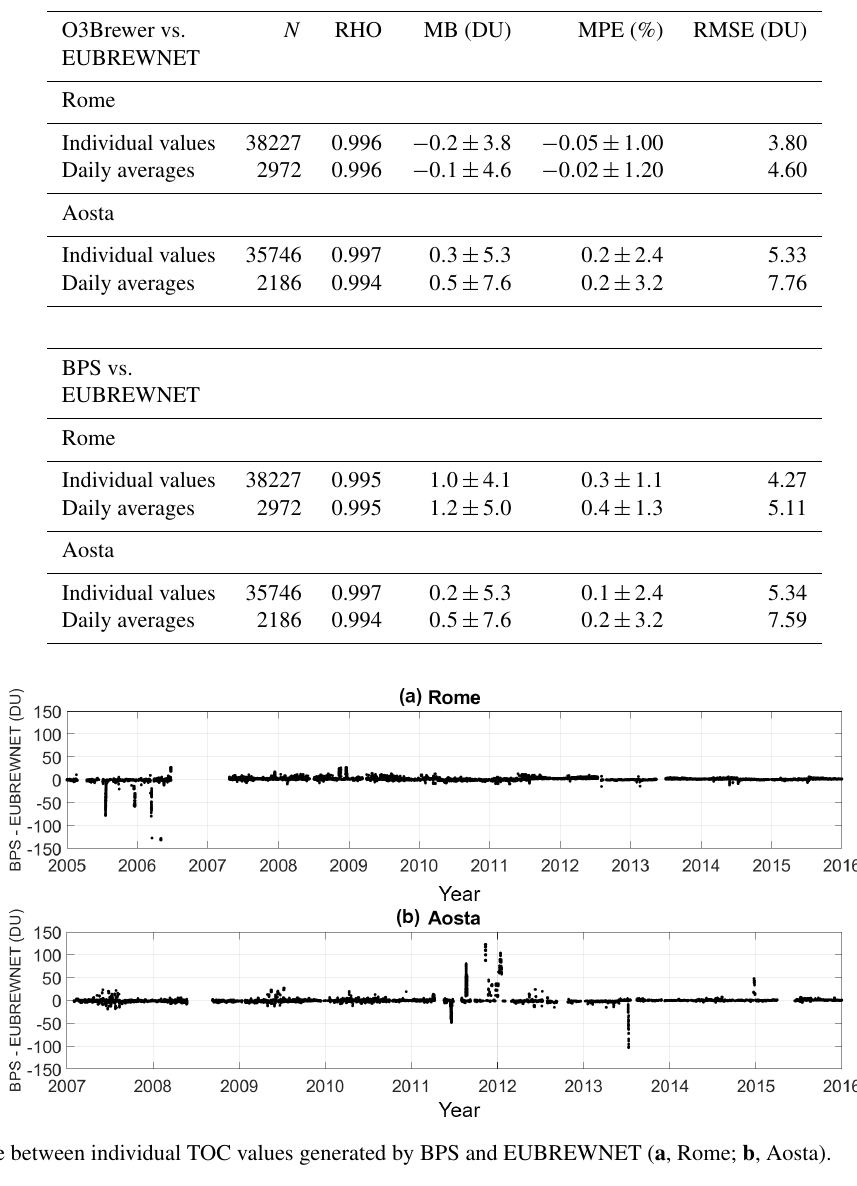
Table 4. Summary of the statistics of O3Brewer vs. EUBREWNET and BPS vs. EUBREWNET at both sites (N: number of data; RHO: Spearman correlation; MB: mean bias; MPE: mean percentage error; RMSE: root mean square error; the uncertainty of MB and MPE is characterized by the standard deviation).